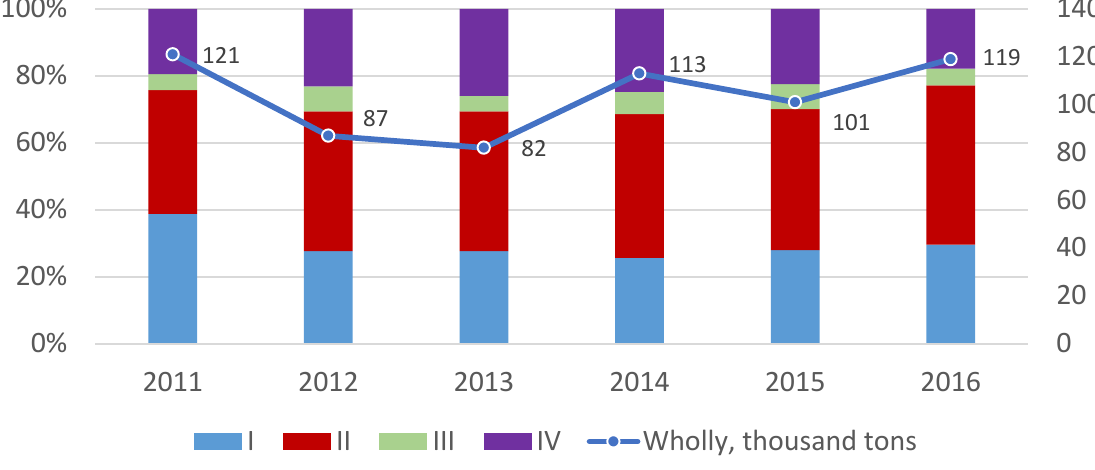
Figure 5. Dynamics of vegetable import in